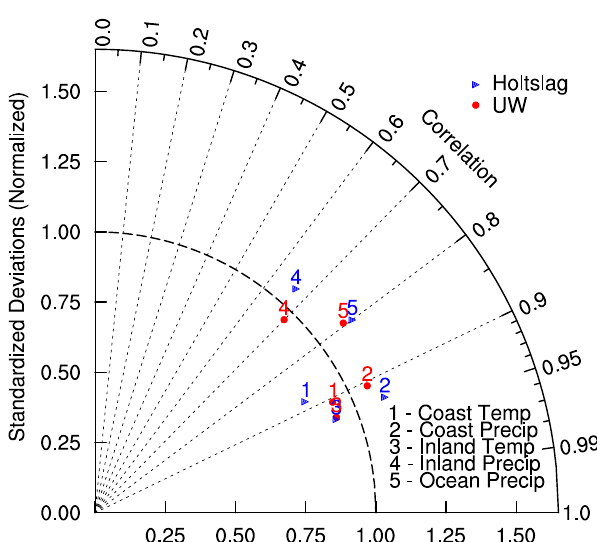
Fig. 5. A Taylor diagram showing the performance of RegCM vs. CRU for the UW and Holtslag models on the WNA domain. The analysis is divided between temperature and precipitation and be- tween coastal grid cells and inland grid